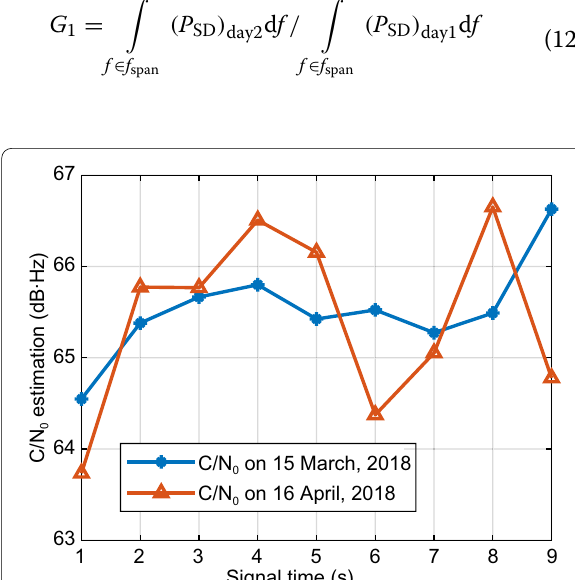
Fig. 6 The C/N 0 estimation of L1C/A signal of GPS Block IIF-10 in high-gain antenna samples. The samples were recorded on 15